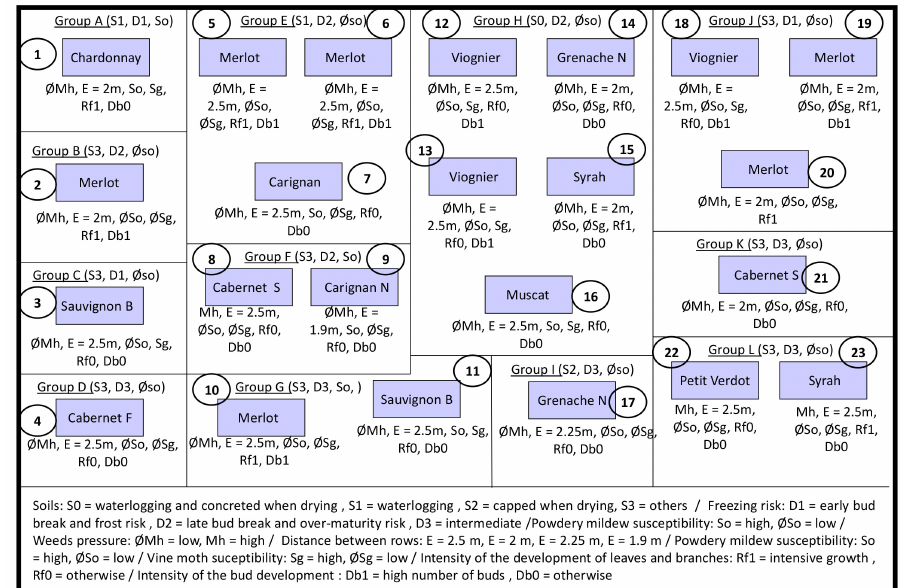
Figure 2. Farm area for the case study. The geographical groups of fields spatially separated, lettered from A to L and delimited by black lines, are characterized by three variables: soils, frost risk and powdery mildew susceptibility. Each field, numbered from 1 to 23, is characterized by the other variables. The various values taken from these variables among the fields illustrate the biophysical heterogeneity throughout the farm area. Variables in italics were not taken into account in the